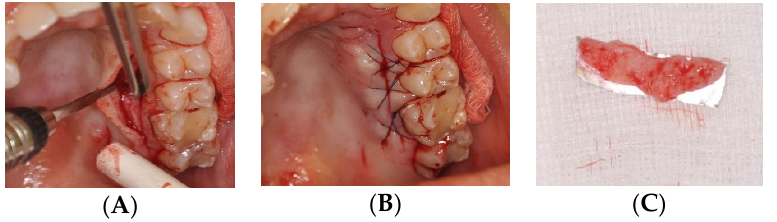
Figure 7. CTG collection: ( A ) Collection of CTG from the palatal masticatory mucosa, ( B ) Primary wound closure with mattress suturing, ( C ) Demonstration of harvested CTG of adequate size.